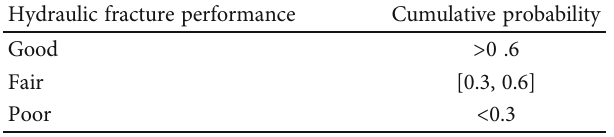
Table 5: Evaluation criteria. Hydraulic fracture performance Cumulative probability